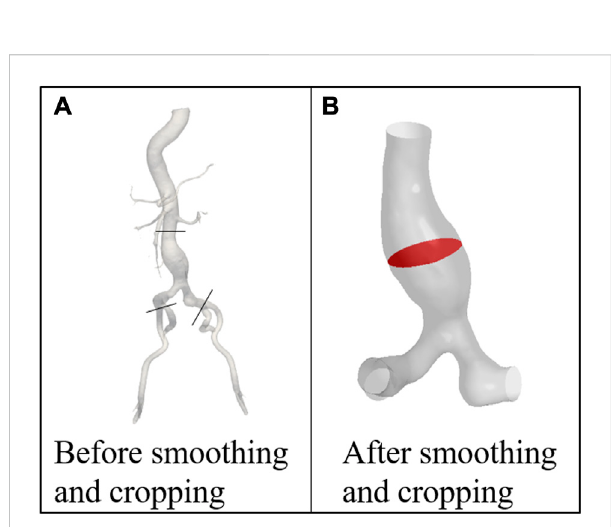
FIGURE 2 Models of the patient (A) before and (B) after smoothing and cropping. POI is marked with red color.